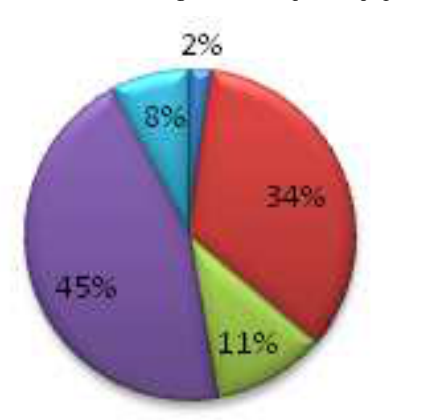
Figure 1: Computer equipment in the schools surveyed